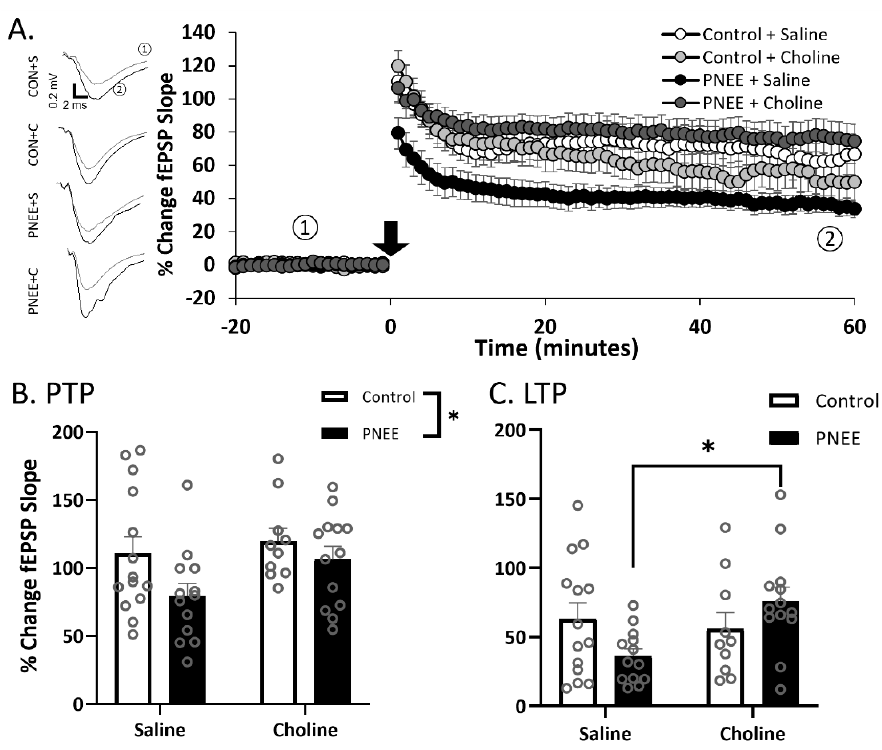
Figure 4. Decreased LTP in juvenile male offspring following PNEE is rescued with choline treat- ment. ( A ) Average LTP for each condition. Each point represents four traces binned to the one- minute interval. The black arrow represents the HFS conditioning stimulus. Representative traces are featured above for ① pre-conditioning and ② post-conditioning. Control + saline = white, control + choline = light grey, PNEE + saline = black, and PNEE + choline = dark grey. Average PTP (( B ); first minute following HFS) and LTP (( C ); minutes 50–60 following HFS) for each condition. * Represents p < 0.05. Error bars are ± SEM. Table 2. Average PTP and LTP for male and female juvenile offspring ±